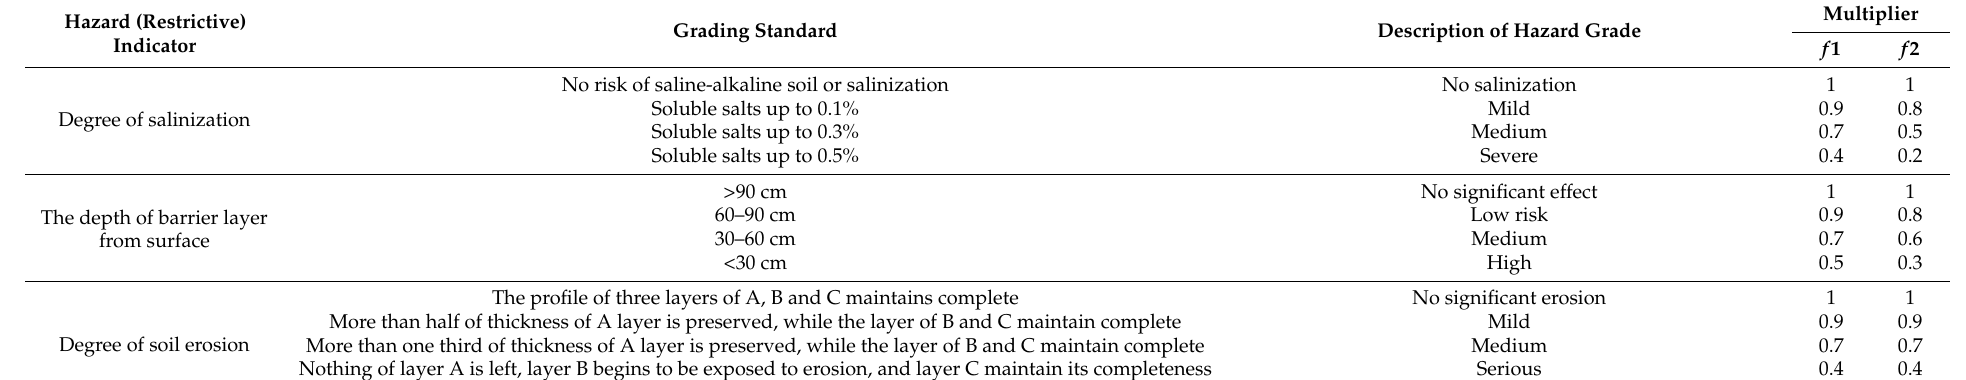
Table 3. Grading reference for hazard indicators of SH